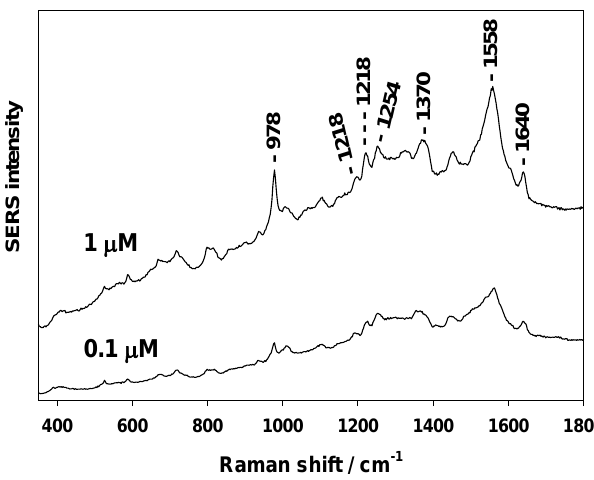
Figure 6. SERS spectra of 5,10,15,20-tetrakis (1-methyl-4-pyridyl)porphyrin (TMPyP).